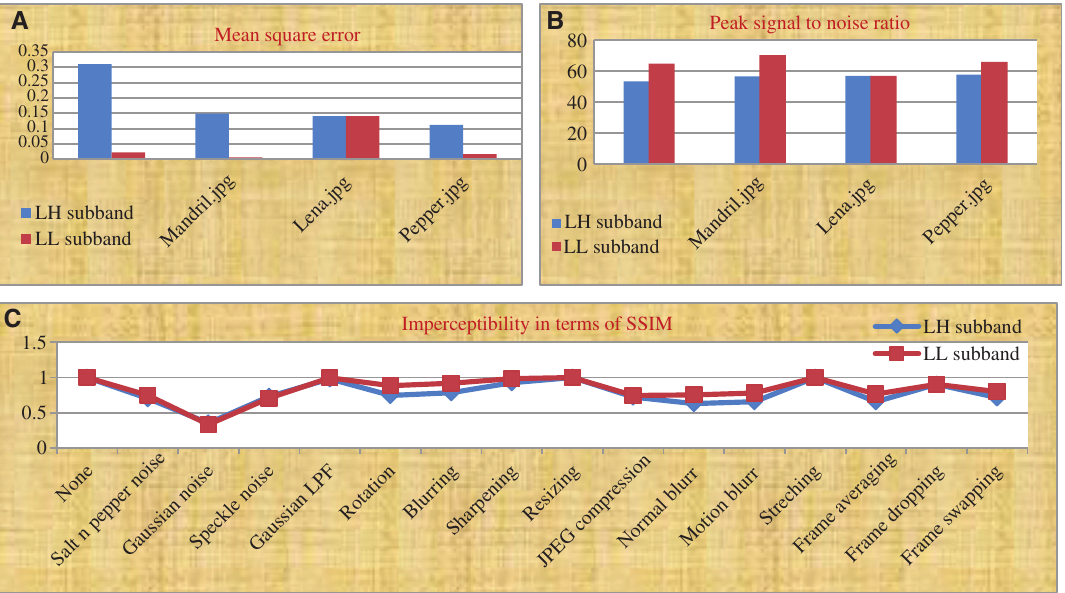
Figure 4: Comparative Performance Analysis of Encoder Algorithms and Algorithm 2 (Imperceptibility Measurement). (A) MSE; (B) PSNR; and (C)